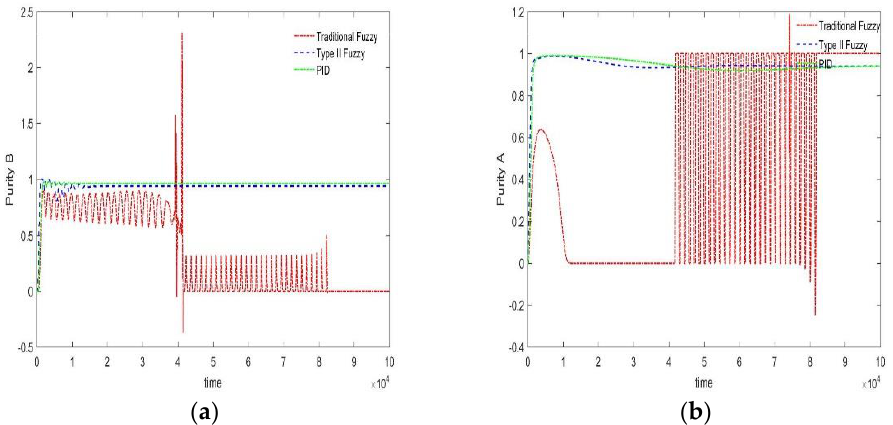
Figure 13. The control results of the three controllers (switch time = 178 s; desired A = 94%, desired B = 96%). ( a ) Extraction outlet (material B); ( b ) raffinate outlet (material A).